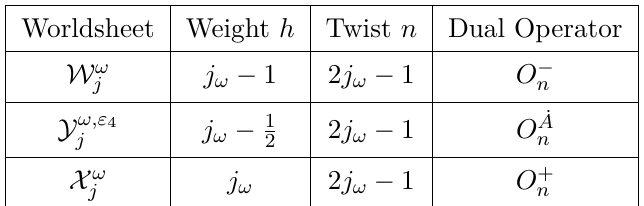
= − 1 − ω field. The ψ